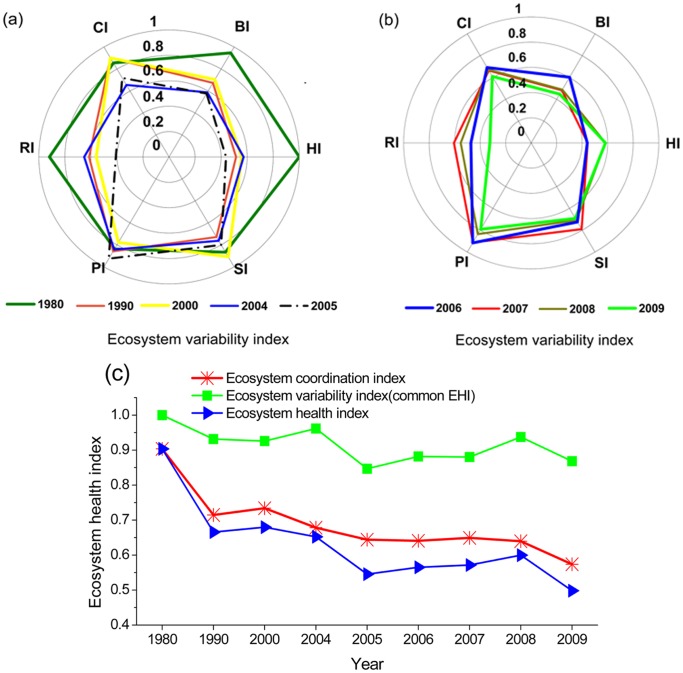
Trends of ecosystem health index in the Pearl River Estuary.(a) the ecosystem variability indexes from 1980 to 2005, (b) the ecosystem variability indexes from 2005 to 2009, (c) the ecosystem health index from 1980 to 2009.